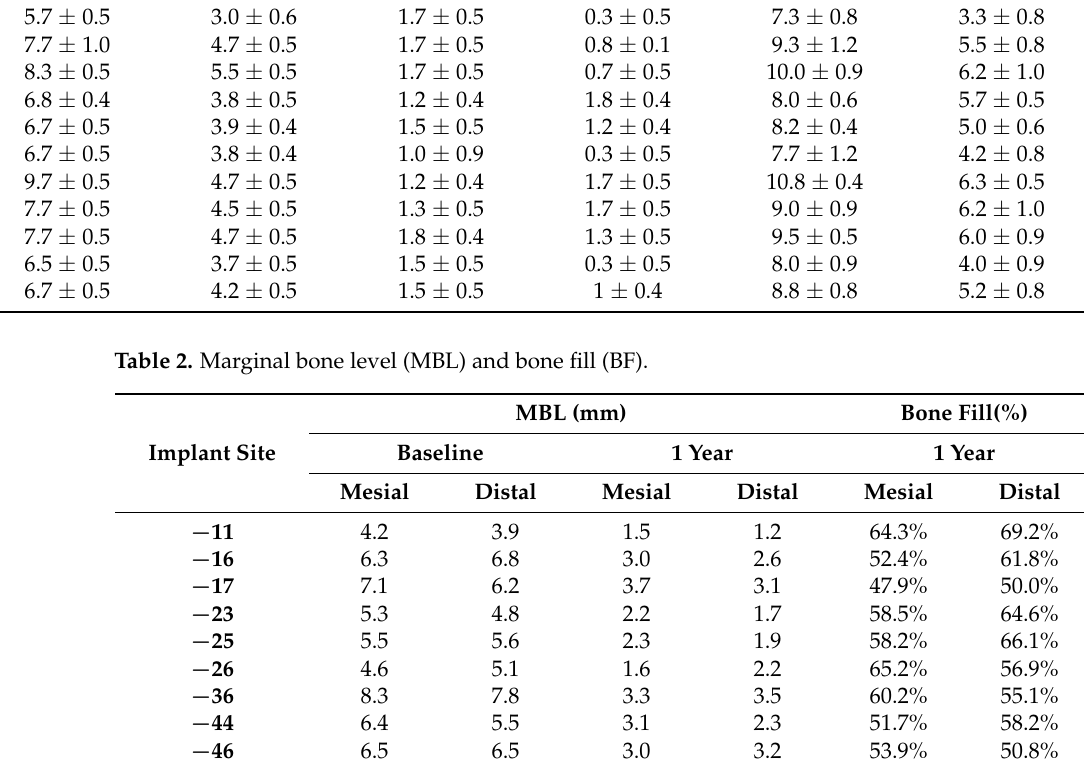
Table 1. Mean of clinical values: pocket probing depth, marginal recession and clinical attachment level (PPD, MR, CAL) taken at baseline and 12 months + standard deviation evaluated at six sites around each implant. Implant Site